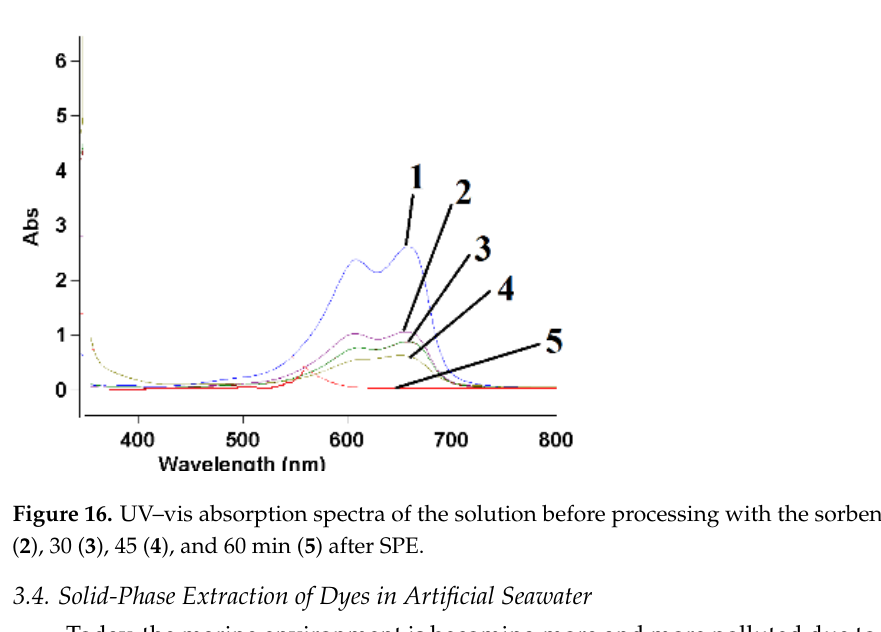
Table 4. Chemical composition of artificial